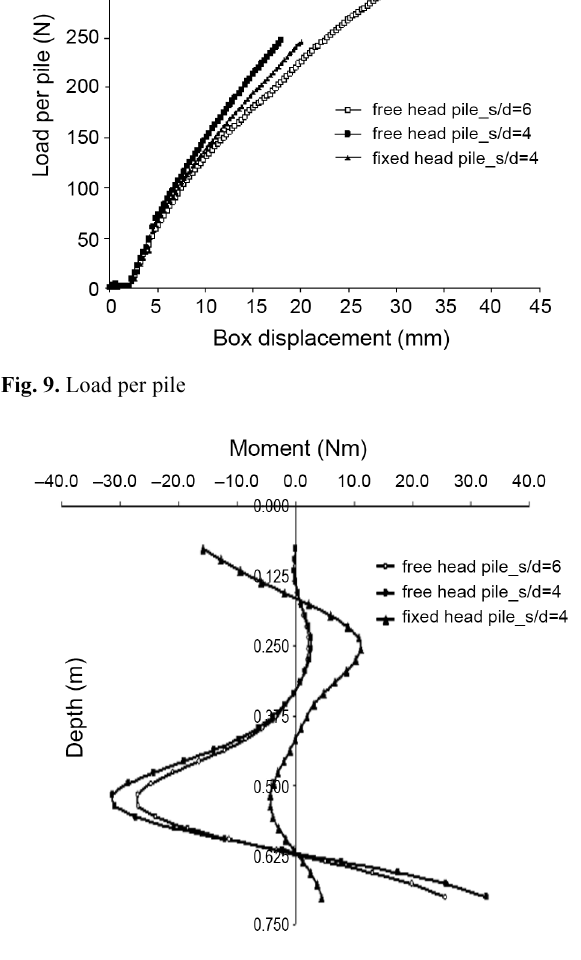
Fig. 10. Bending Moment Distributions at the 18 mm box disp- lacement